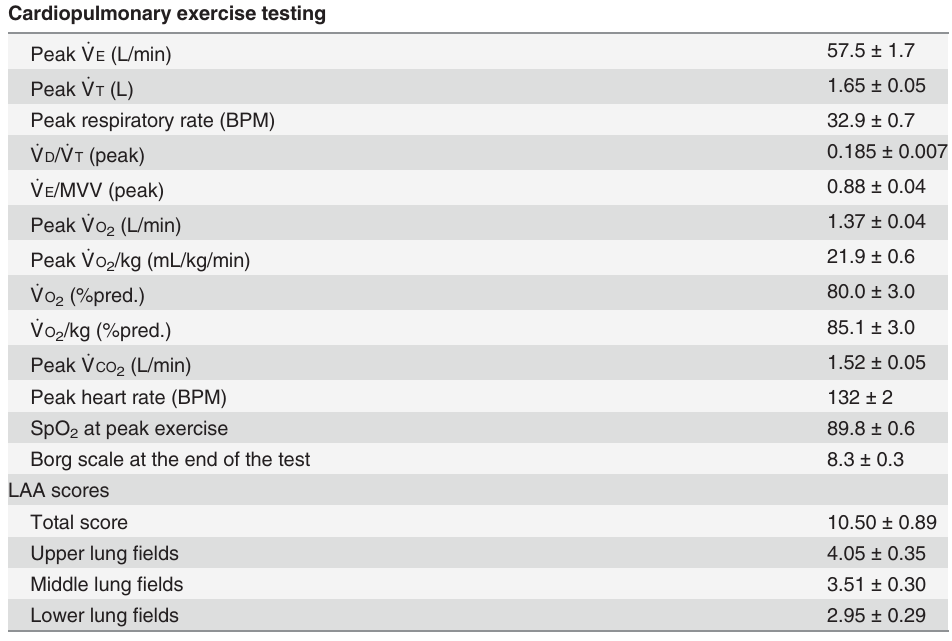
Table 2. Cardiopulmonary exercise testing data and LAA scores at study entry. Cardiopulmonary exercise